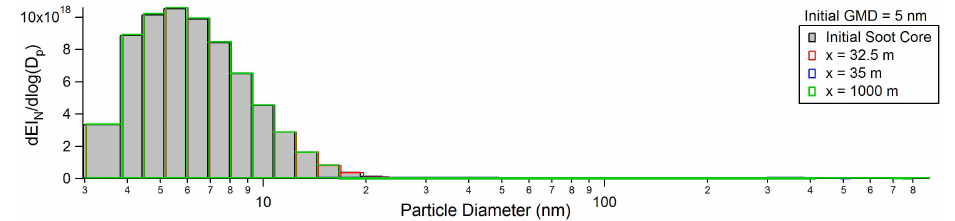
Fig. 9. Simulation results show no significant ice coated soot particle growth when initial soot core concentration is 1 × 10 10 cc − 1 and GMD of initial soot particle size distribution is